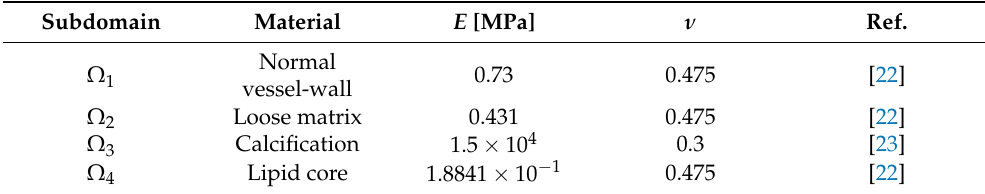
Table 3. Material parameters of the piece-wise homogeneous domain Ω = (cid:83) 4 vessel wall, loose matrix, calcification, and lipid core), E (Young’s modulus) and ν (Poisson ratio).